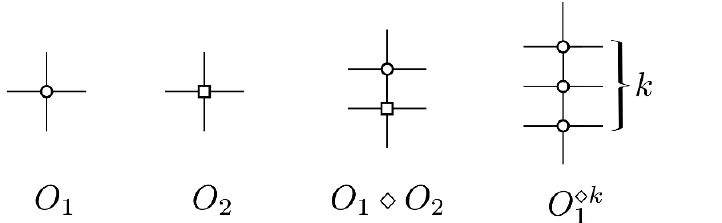
Figure 9 . The product of two MPO tensors O 1 and O 2 , as well as the power O (cid:5) k